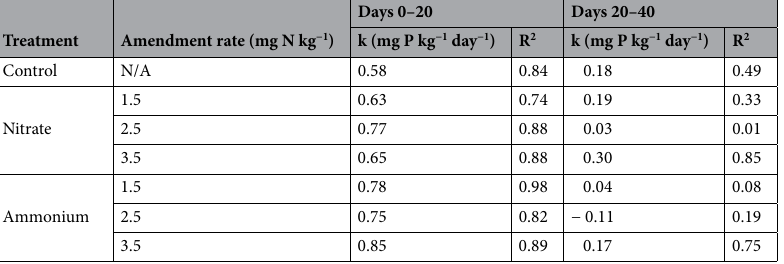
Table 1. Phosphorus mineralization rates from days 0–15 and days 15–40, as affected by N species and amendment rate. The rates were calculated using a zero-order kinetic model, where P min = k · time. P min equals changes in labile inorganic P (mg P kg −1 day −1